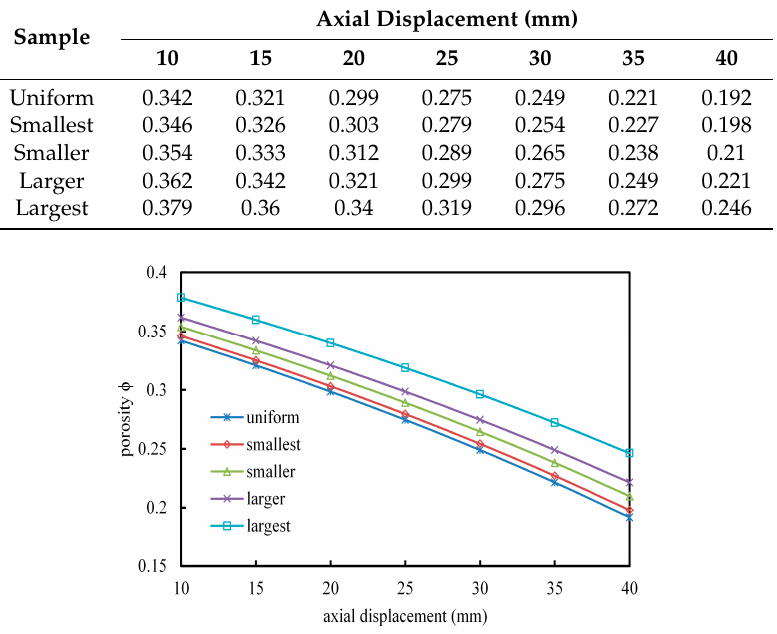
Figure 8. Porosity of non-cemented coal sample of each axial displacement.